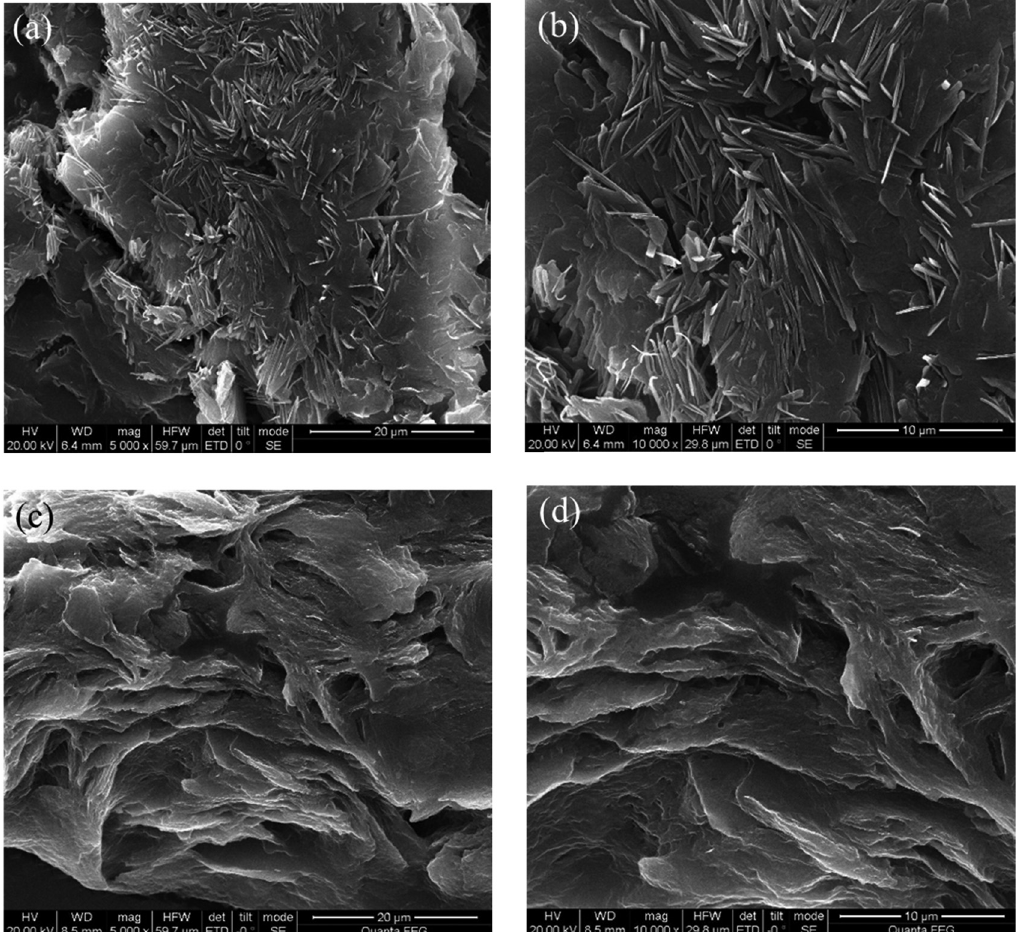
Figure 8: ( a and b ) FE - SEM images of the product before and ( c and d ) after the hydrolysis